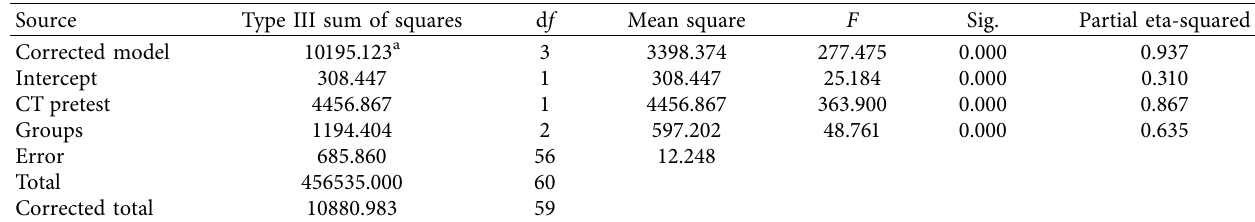
Table 10: Results of tests of between-subjects efects for critical thinking.